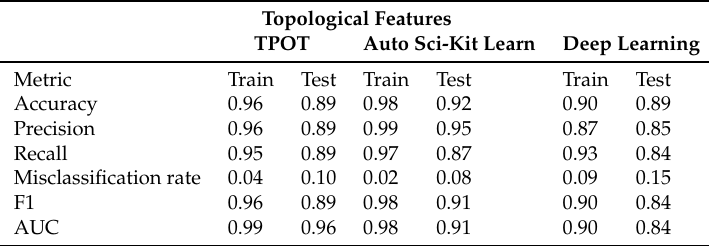
Table 4. Machine Learning Accuracy—Topological and Textural